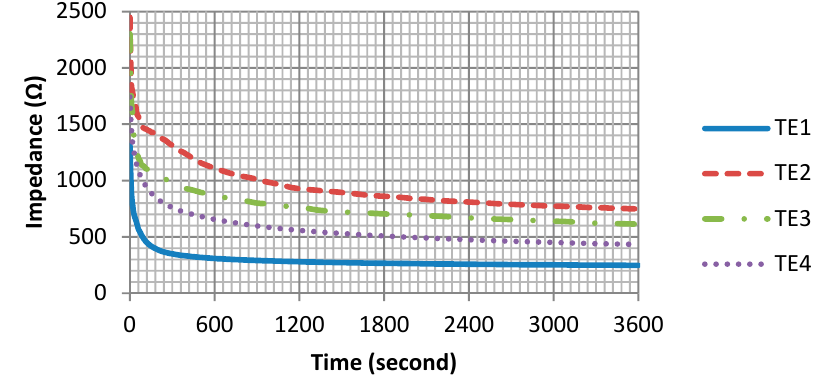
Figure 5. Skin-electrode impedance in 1 h.